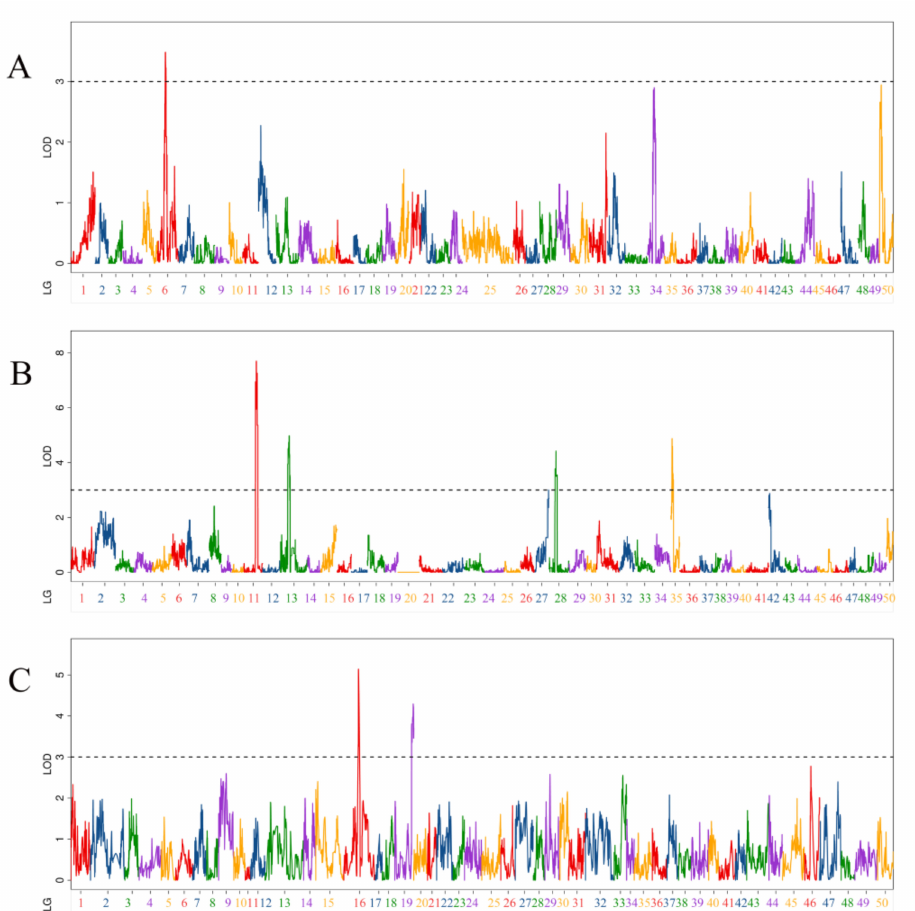
Figure 1. Distribution of body length-related QTL across 50 linkage groups of Yellow River carp from the maternal ( A ), paternal ( B ), and HH maps ( C ). Table 3. Body height-associated QTL identified in Yellow River carp 5–17 months after hatching.